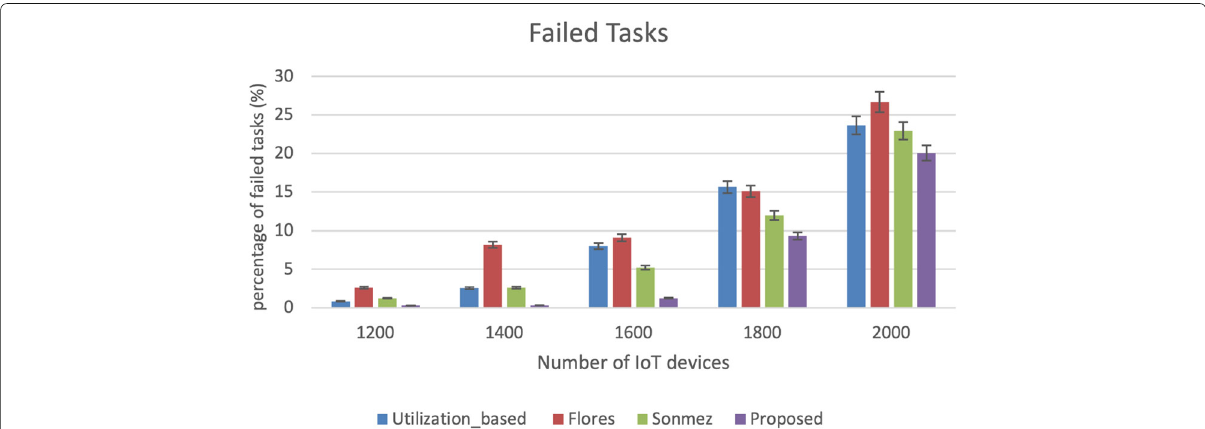
Fig. 12 Percentage of failed tasks of the proposed approach with other related approaches part 2